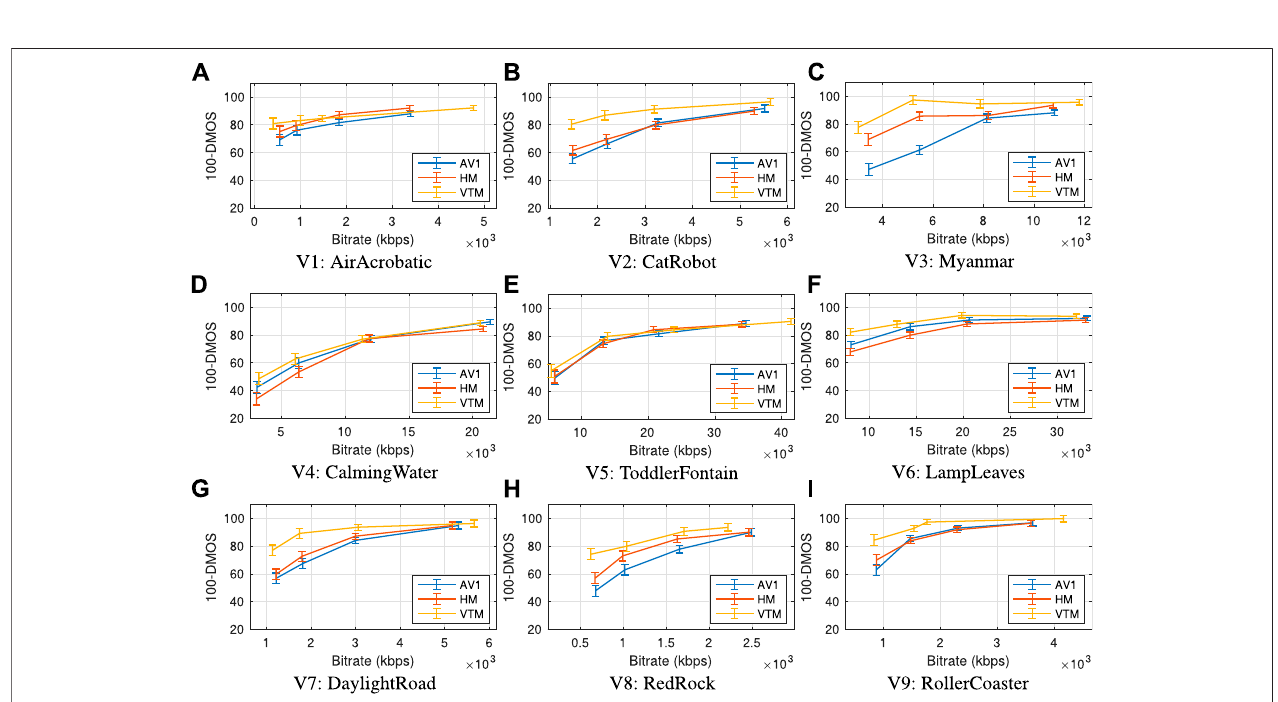
FIGURE 5 | The DMOS-Rate curves for all sequences (A – I) of Resolution Group B and all three codecs along with the standard error bars after compensating for subject bias, as described in Recommendation P.913 (2021).